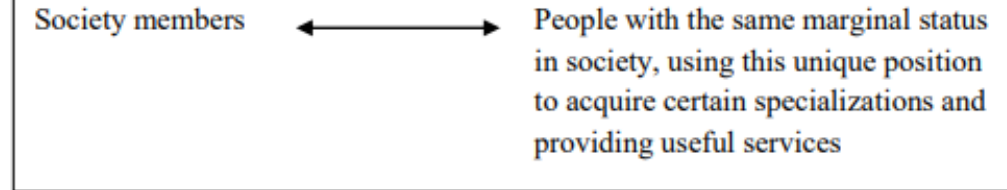
Diagram 2. Professional Specific Orientations